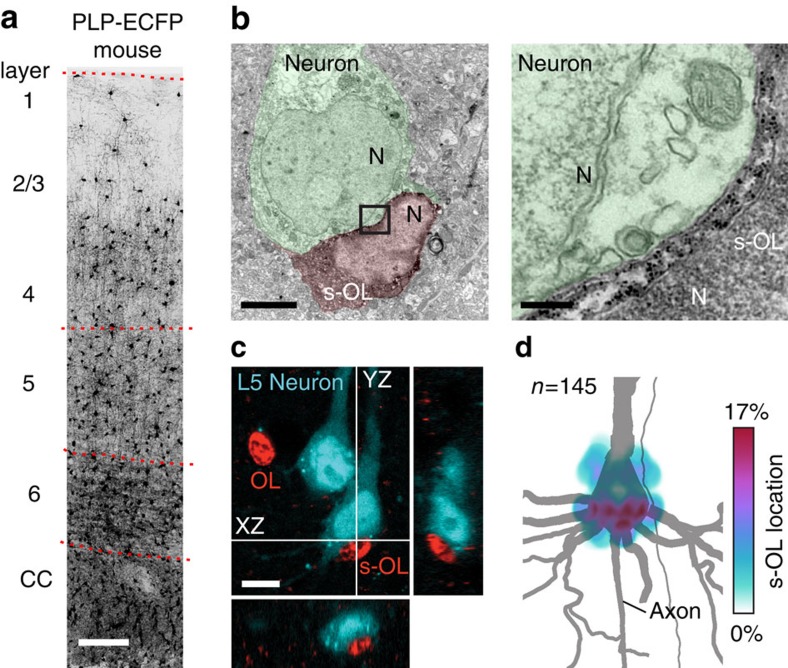
Identification and distribution of s-OLs around pyramidal neurons.(a) Overview image of oligodendrocytes in the somatosensory neocortex labelled for ECFP in the transgenic PLP-ECFP mouse. Scale bar, 150 μm. (b) Left: s-OL (red pseudo-colour) in a PLP-ECFP mouse neocortex exhibits positive immuno-gold labelling in the cell body. The host neuron is pseudocoloured in light green and nuclei are labelled with N. Scale bar, 3 μm. Right: higher magnification image of the box indicated in the left image, which shows a distinct and confined location of gold particle-labelled ECFP in the cell body (black dots). Scale bar, 200 nm. (c) Confocal image of labelled OLs in a PLP-ECFP mouse and two biocytin-filled L5 neurons and corresponding orthogonal views. The s-OL cell body is in direct contact with the neuronal soma. Processes of OLs are not visible because laser intensity was reduced to a minimum. Scale bar, 10 μm. Also, see Supplementary Movie 1. (d) Heatmap illustrating the location probability of 145 s-OLs in relation to the soma of an example L5 neuron (grey). s-OLs were positioned at multiple locations around the soma, but the highest percentages were found around the base of neurons close to the AIS and the basal dendrites. See also Supplementary Fig. 1.